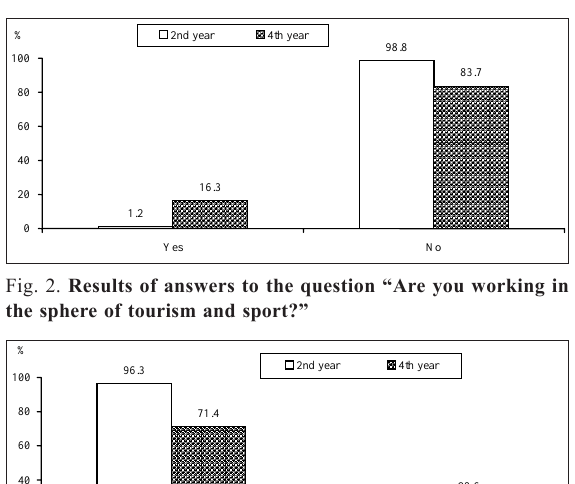
Fig. 1. Students’ satisfaction with the studies at LAPE